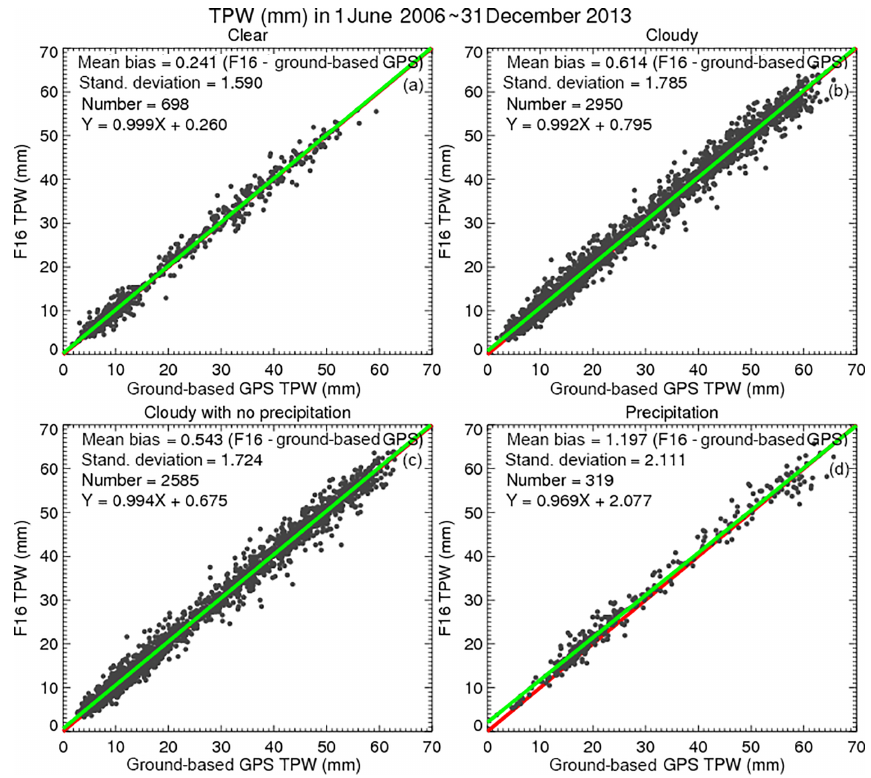
Figure 4. TPW scatter plots for the gb-GPS and RSS version 7.0 F16 SSM/I pairs from June 2006 to December 2013 under (a) clear, (b) cloudy, (c) cloudy but non-precipitating, and (d) precipitating